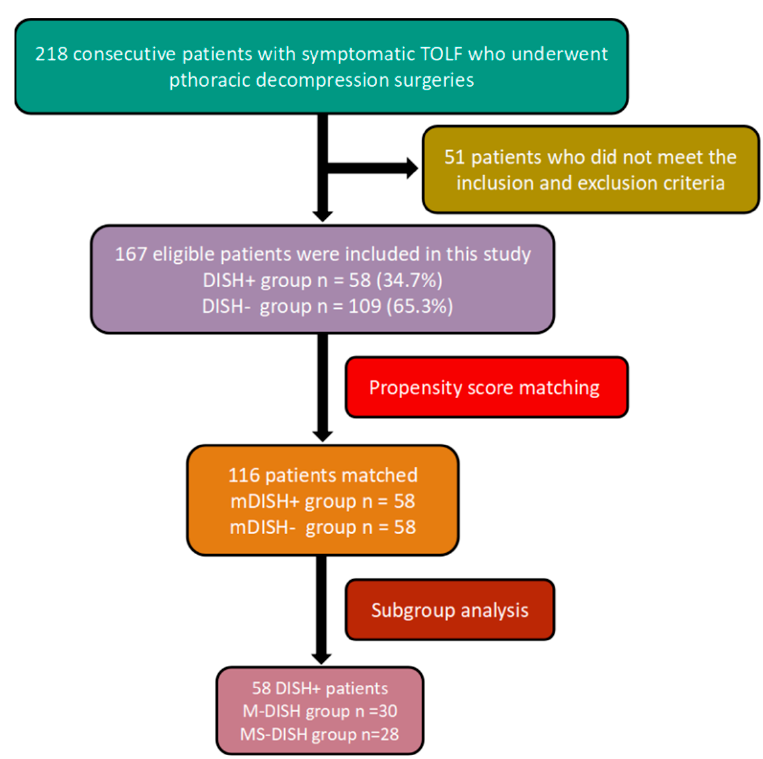
Figure 1. Flowchart of the study population. A total of 116 patients were selected by propensity score matching.